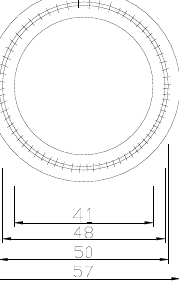
( b ) Figure 18. Shear failure modes of sleeves: ( a ) SJ-1; ( b ) SJ-2. When subjected to a vertical load, the vertical displacement of the sleeve increased linearly during the early and middle stages of loading. In the late loading stage, due to the bending and yielding of part of the main materials near the sleeve weld, the vertical displacement increased significantly until the main material was completely bent and yielded. The experiment showed that the failure mode of the five vertical pole sleeve spec- imens in this group was the yielded steel; no cracks formed in the weld seam at the con- nection between the sleeve and the vertical pole. The failure property was a ductile failure. Therefore, this experiment verified that the welding seam at the connection of the vertical pole sleeve was not damaged before the main material, during the normal use of the form- work support, which met the vertical bearing capacity requirements for the vertical pole of the formwork support. 3.2.4. Finite Element Comparative Analysis of the Shear Capacity of the Sleeve on the Vertical Pole The sleeve model was composed of a vertical pole and a sleeve, and the model was established according to the actual size of the element. The vertical pole and the sleeve were one entity; the weld element unit system was ignored. The vertical pole and the sleeve material were both made of Q235 steel. As shown in Figure 5, the proximate global size was set to 0.02, and the meshing method was set to Sweep. The vertical pole and sleeve grids were automatically divided. The numerical model is shown in Figure 19. In